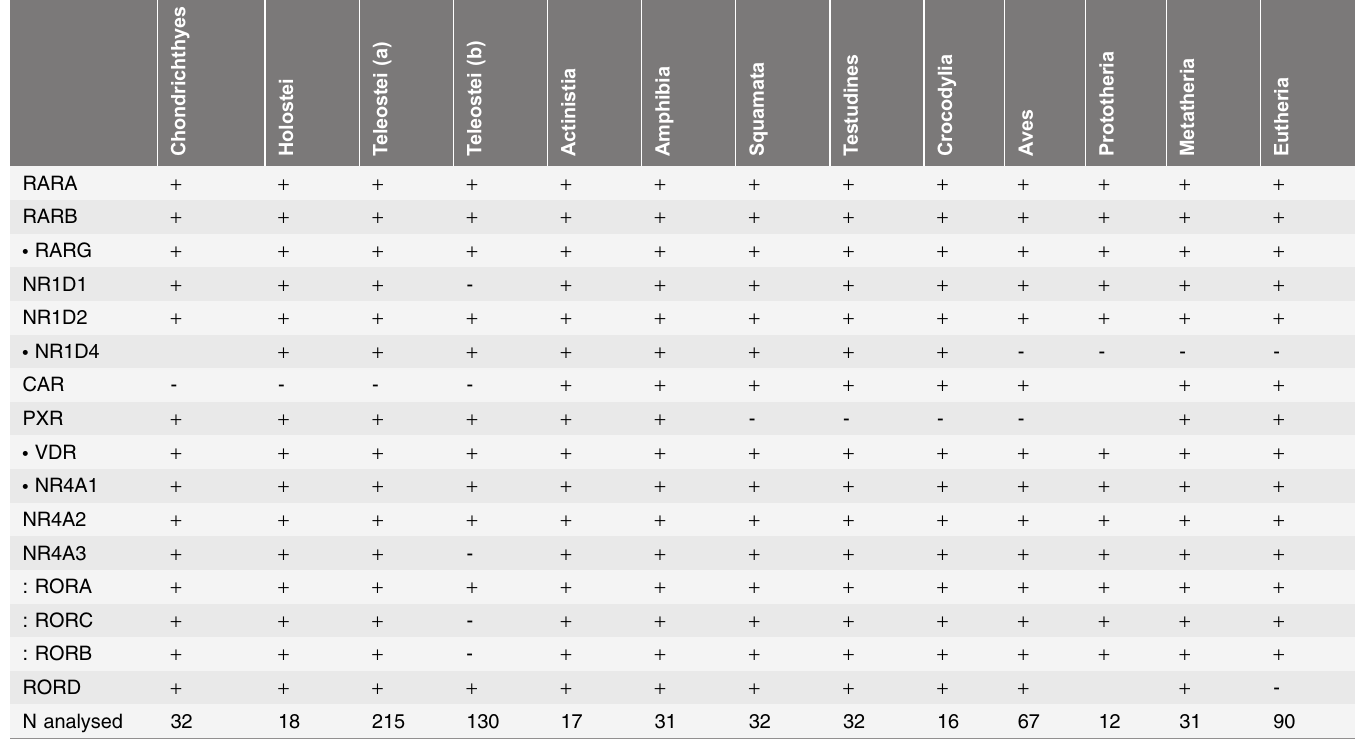
Table 2. Presence and absence of gnathostome nuclear receptor subfamilies with syntenic paralogs ( N ) to aqp0, -14, -2, -5, -5L, -6, or (:)